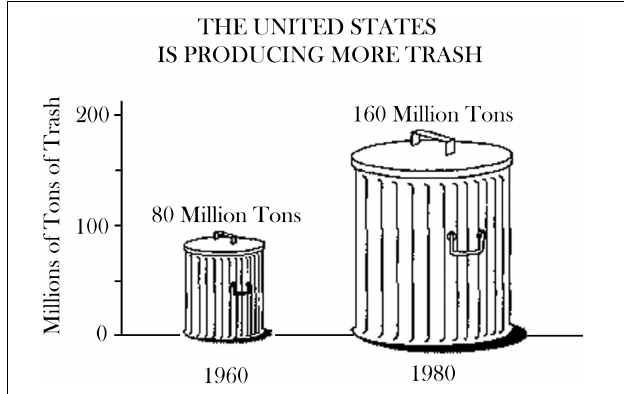
are based on nonlinear relationships has been termed the illusion of linearity . This phenomenon has been replicated in several studies (e.g., De Bock et al., 2002; Vlahovi´c-Šteti´c et al., 2010) and could be demonstrated even among university students (Esteley et al.,